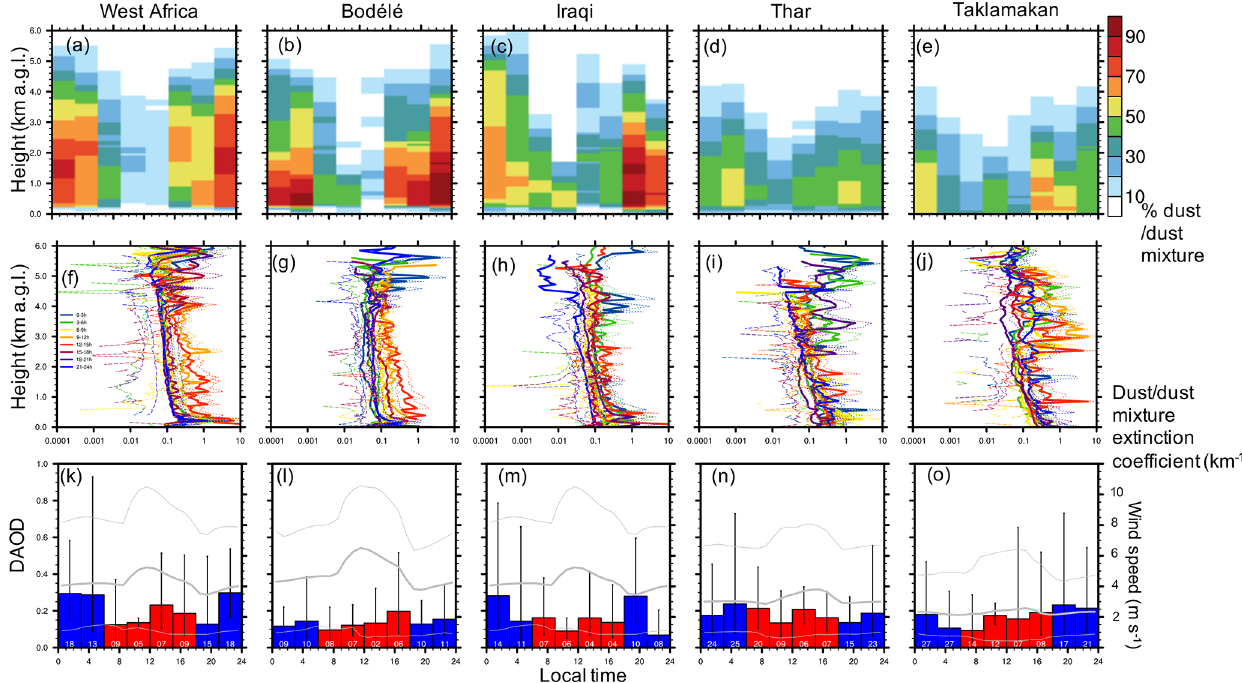
Figure 13. Diurnal cycle of dust and dust mixture characteristics observed by CATS over five key dust source regions during boreal autumn (September–November, SON). Figure elements are the same as in Fig.